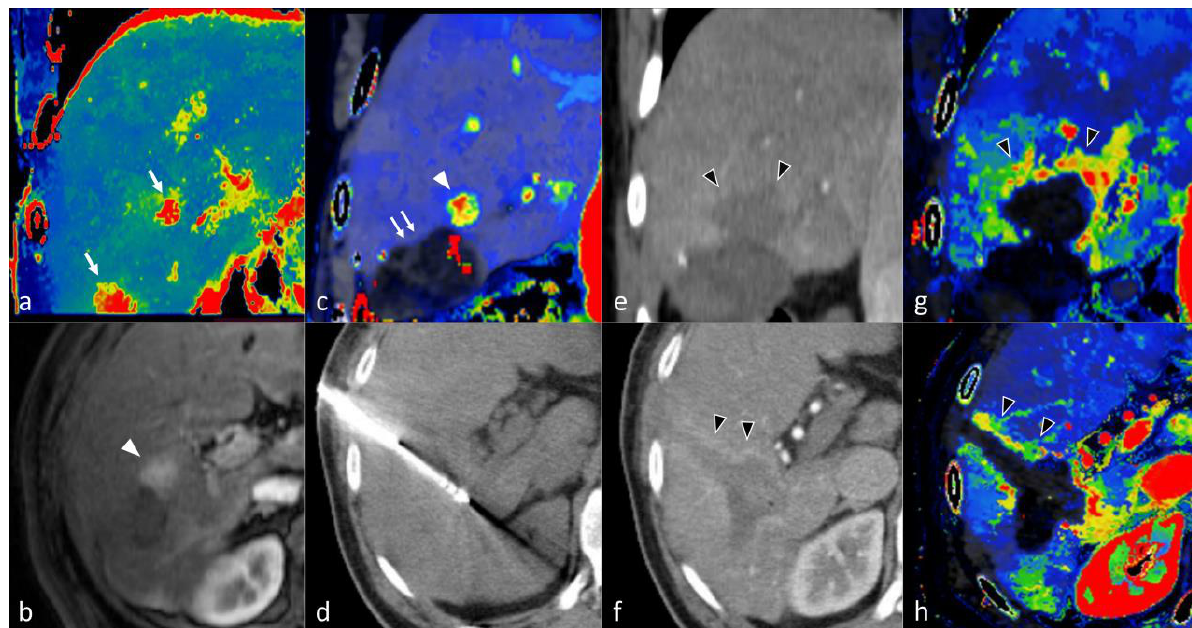
Figure 15. Expected post-treatment changes after microwave ablation (MWA). During US screening examination of a 70-years-old cirrhotic patient, two suspicious nodules, one 2 cm in segment VI and one 1.2 cm more centrally, were found. ( a ) Mean Slope of Increase (MSI) map of CT Liver Perfusion (CTLP) in coronal plane of the same patient shows the two hypervascular lesions in the right liver lobe, both of which proved to be HCCs (arrows). A wedge resection of the inferior tumor was performed. Post-operative arterial phase MRI in axial plane ( b ) and MSI map of CLTP in coronal plane ( c ) revealed once again the centrally-located viable tumor (arrowhead) alongside post-operative changes in the area of the resection (double arrows). A percutaneous MWA of the remaining tumor was subsequently decided. ( d ) Axial non-enhanced periprocedural CT shows the microwave antenna placed inside the tumor. Post-procedural portal phase CT in coronal ( e ) and axial ( f ) plane shows lack of contrast enhancement due to coagulative necrosis in the ablation zone and needle tract with surrounding hyperemia (black arrowheads). Note the safe ablation margin compared to reference images ( b , c ). MSI map of follow-up CTLP one month later in coronal ( g ) and axial plane ( h ) shows remaining hyperemia adjacent to the ablation margin, which should not be interpreted as residual or recurrent tumor.